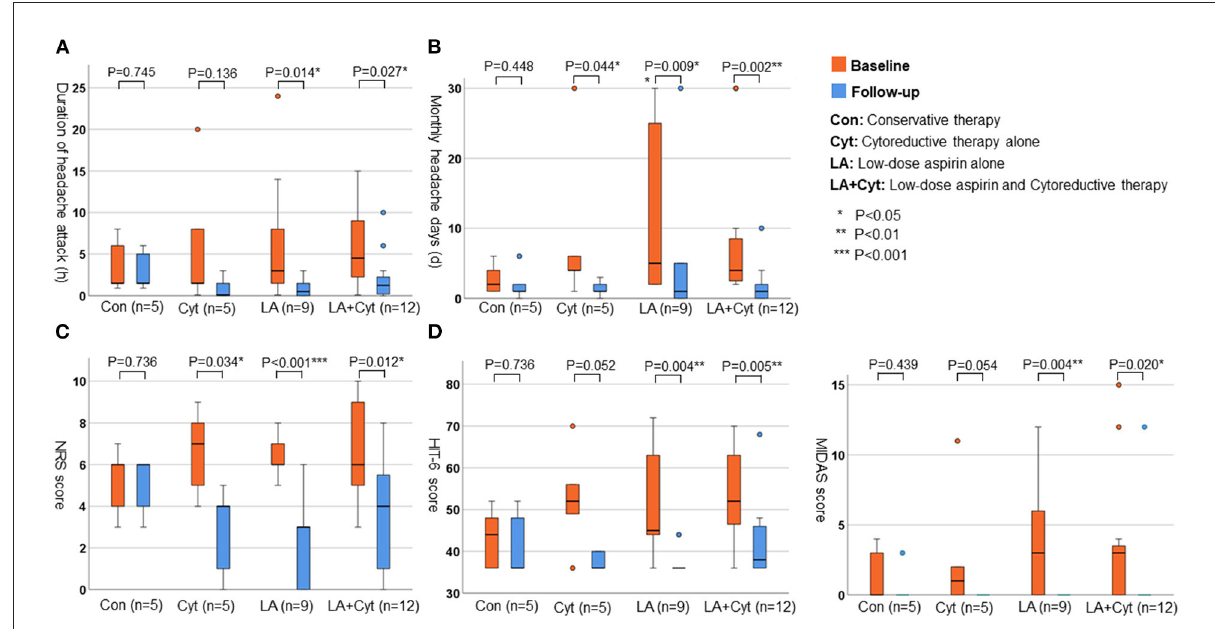
FIGURE4 The changes of parameters for headache according to the treatments. (A) Average duration of headache attack (h). (B) Monthly numbers of headache days (d). (C) NRS score. (D) HIT-6 score.